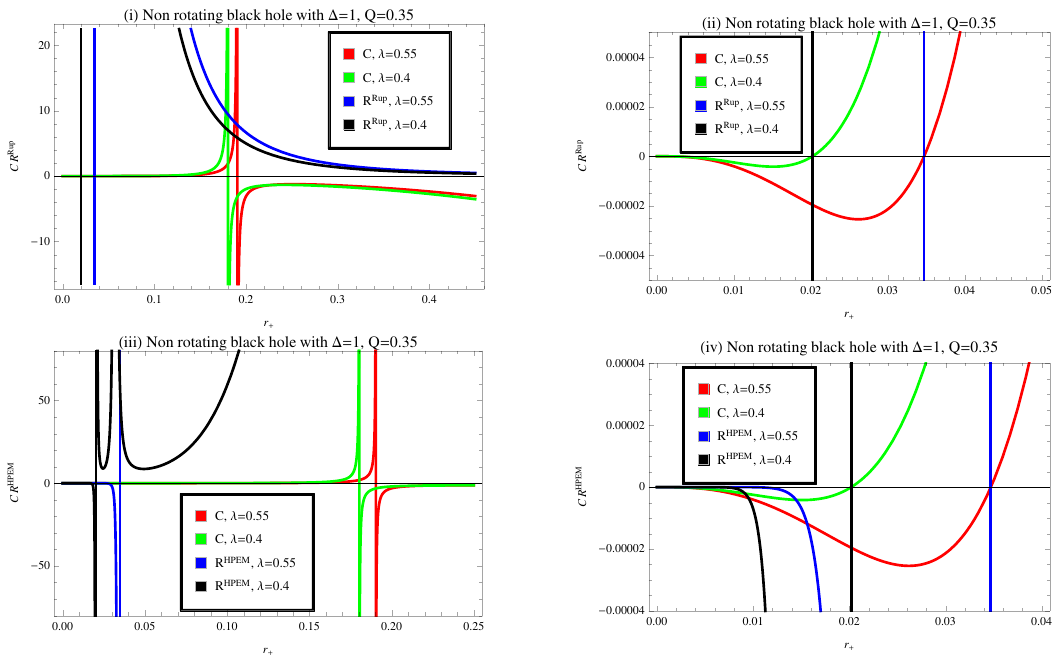
Figure 5. Plots of heat capacity C v , curvature scalar of HPEM and Ruppeiner metrics versus horizon radius r + for CMG corrected non-rotating regular